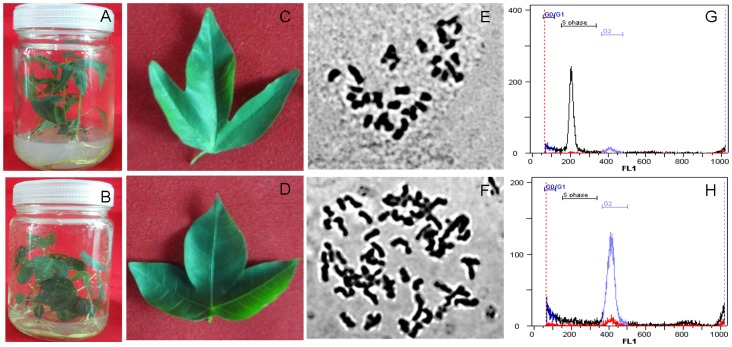
Standard chromosome counting and flow cytometric analysis of different ploidy levels in cassava cultivar NZ199 leaves.A, in vitro plantlets of cassava diploid genotype; B, in vitro plantlets of cassava autotetraploid genotype; C, leaf of cassava diploid genotype; D, leaf of cassava autotetraploid genotype; E, chromosome number of diploid genotype (2n = 2x = 36); F, chromosome number of autotetraploid genotype (4n = 4x = 72); G, a fluorescence peak of diploid nuclei located at channel position 200; H, a fluorescence peak of autotetraploid nuclei located at channel position 400.